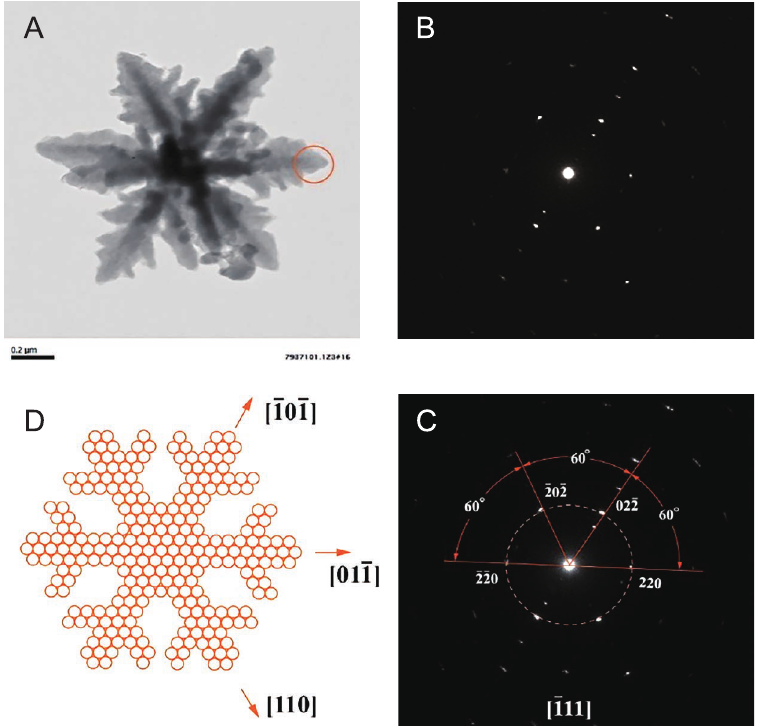
Fig. 4 TEM image ( A ) of the silver dendrites synthesized. Selected area electron diffraction patterns ( B, C ) from the specific sites labeled in ( A ). D is the growth model of silver dendrites.